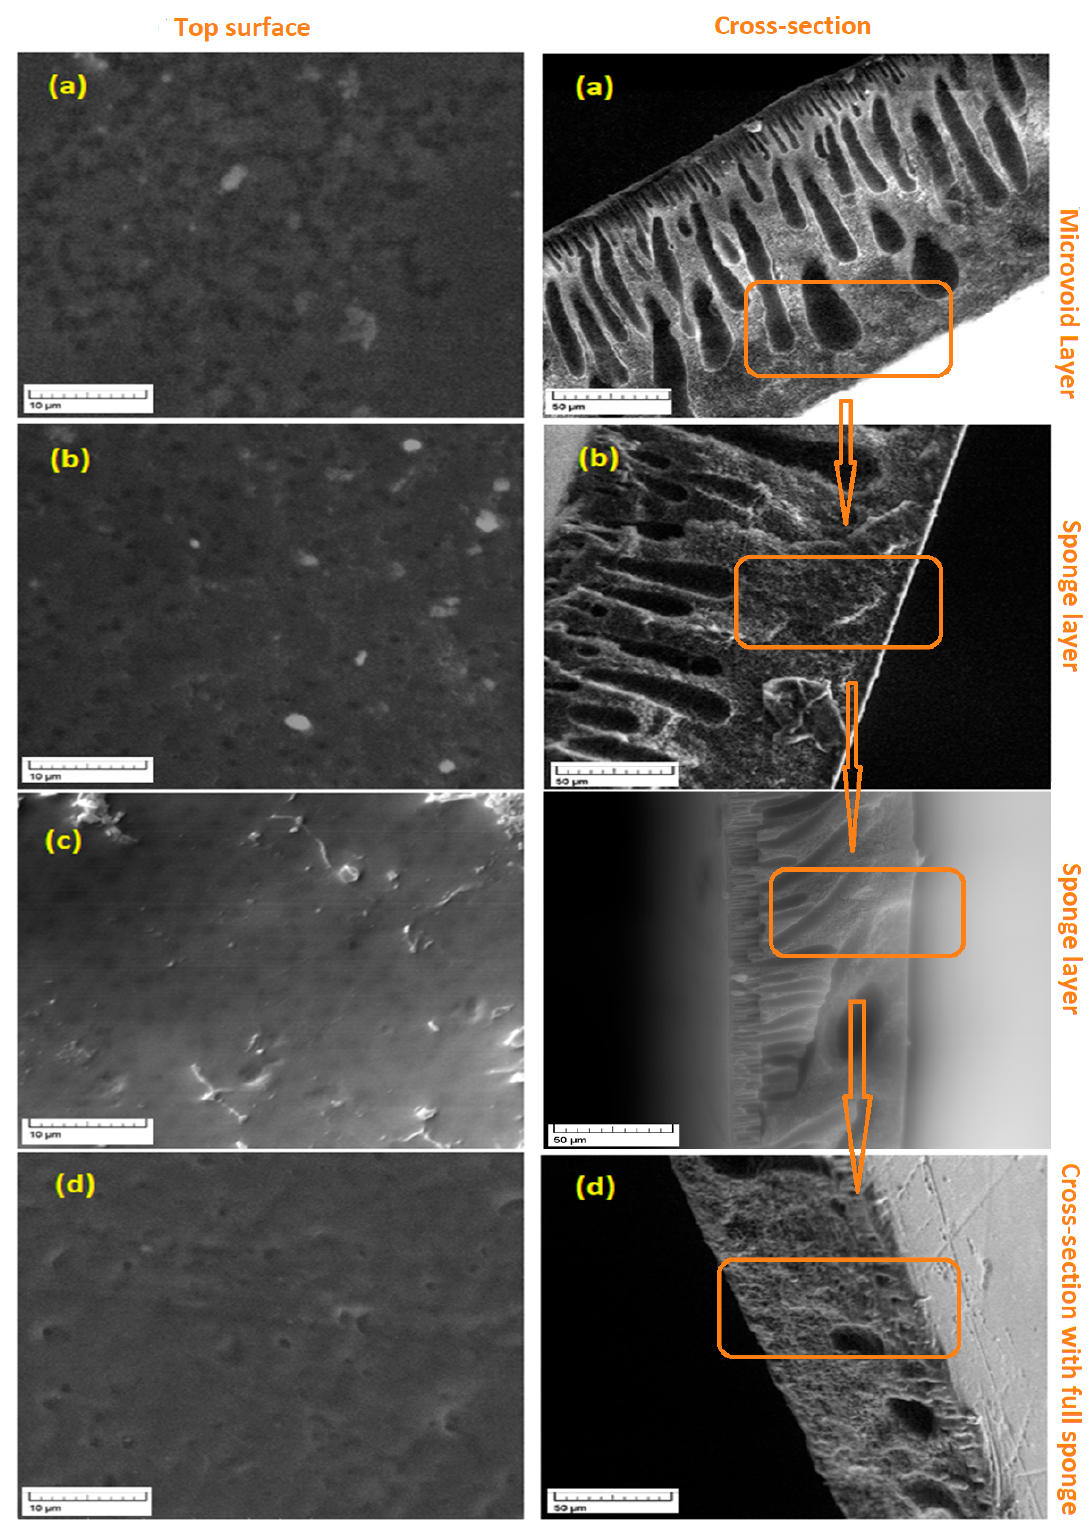
Figure 4. SEM images of cross ‐ section and top surface of the membranes ( a ) PPSU 20 /PSU 0 , ( b ) PPSU 20 /PSU 6 ( c ) PPSU 20 /PSU 7 , ( d ) PPSU 20 /PSU 9 .